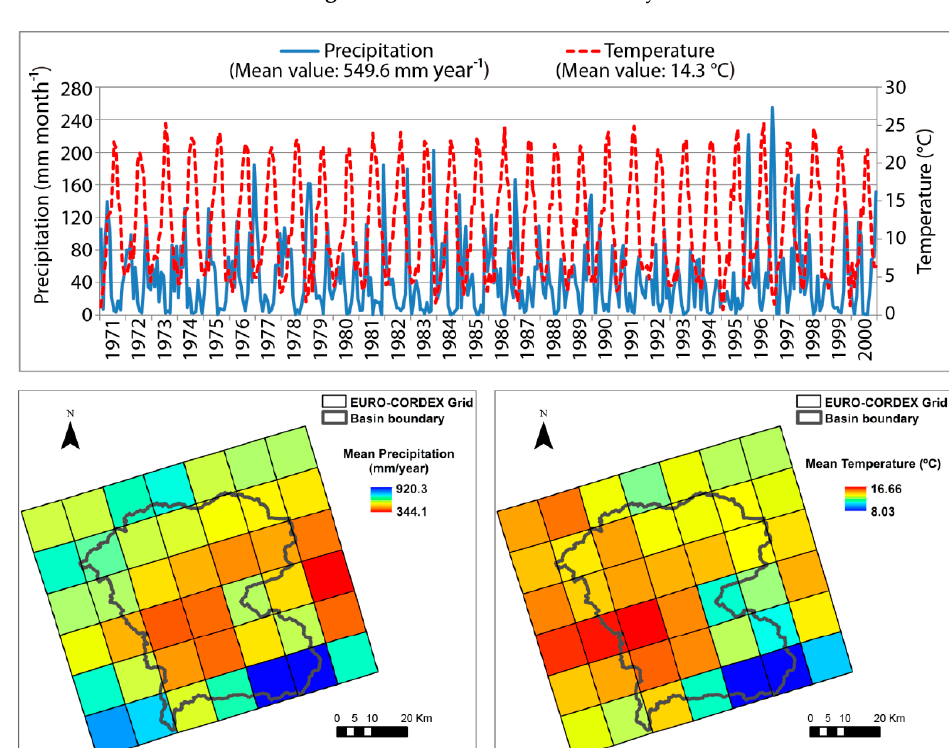
Figure 3. Historical precipitation and temperature in Alto Genil basin. Above: Monthly precipitation and temperature time series. Below: Spatial distribution of mean precipitation and temperature.